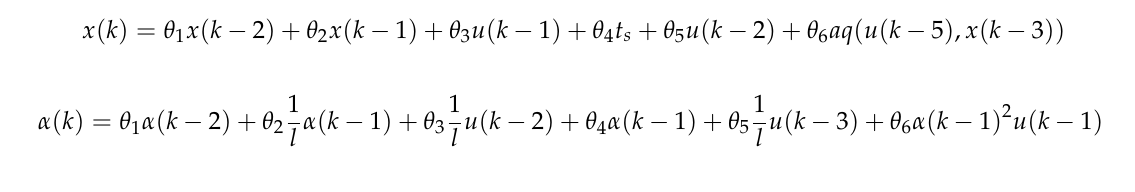
Table 3. Gene weights for the position and sway predictor.